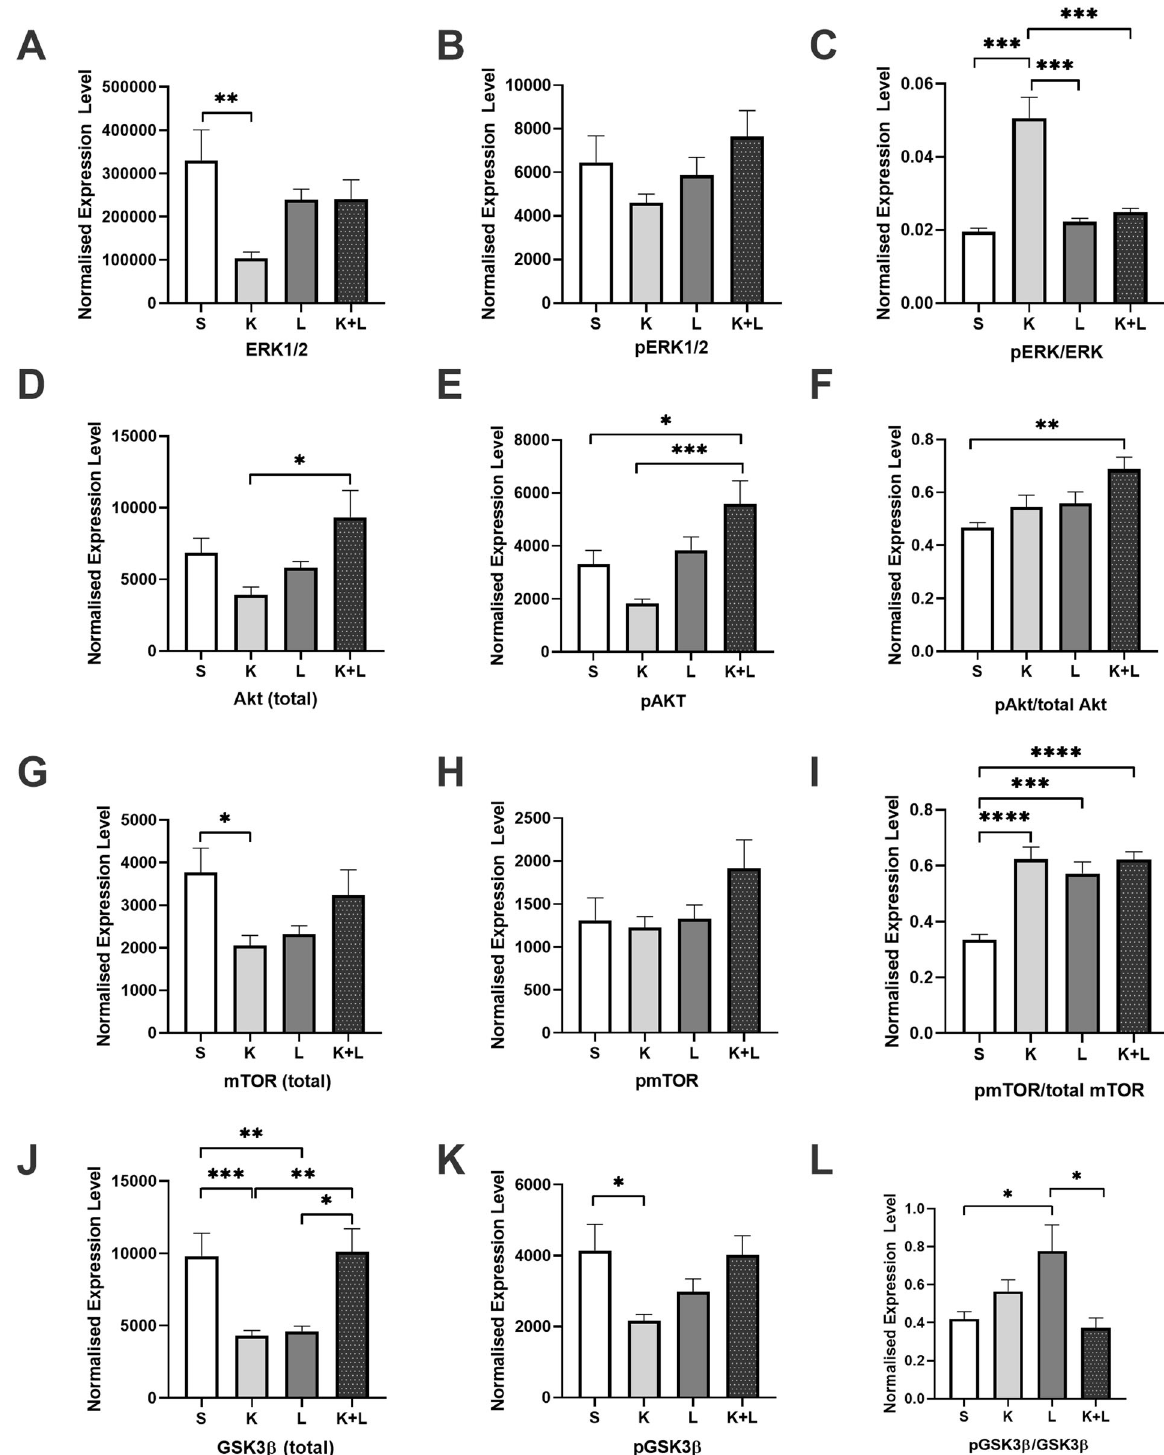
Fig. 3 Infralimbic cortex protein expression in response to treatment. The effect of ketamine and lithium treatment on protein signaling pro fi les in the infralimbic cortex were examined via western blotting. Proteins of interest include total ERK1/2 ( A ), p ERK1/2 ( B ), p ERK1/2/ERK1/2 ( C ), total Akt ( D ), p Akt ( E ), p Akt/Akt ( F ), mTOR ( G ), p mTOR ( H ), and p mTOR/mTOR ( I ), GSK3ß ( J ), p GSK3ß ( K ), and p GSK3ß/GSK3ß ( L ). ERK1/2 extracellular signal-regulated kinases 1/2, p phosphorylated, Akt protein kinase B, mTOR mammalian target of rapamycin, GSK3ß glycogen synthase kinase-3 ß. Treatment groups: S: saline; K: ketamine; L: lithium; K + L: ketamine + lithium. * p < 0.05; ** p < 0.01; *** p < 0.001; **** p <